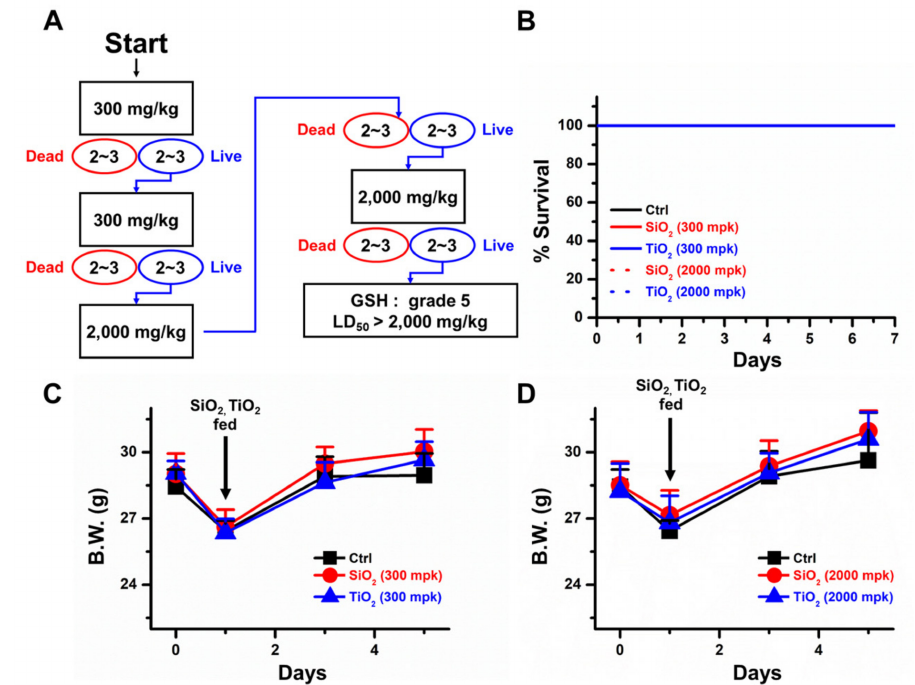
Figure 4. In vivo acute oral toxicity assessment of SiO 2 and TiO 2 nanoparticles. ( A ) Toxicity assessment scheme. ( B ) % survival of mice after oral feeding of 300 and 2000 mg / kg SiO 2 and TiO 2 nanoparticles. ( C ) Body weight changes induced by 300 mg / kg SiO 2 and TiO 2 nanoparticles. ( D ) Body weight changes in the 300 mg / kg SiO 2 and TiO 2 nanoparticle-treated mice. Error bars represent the standard